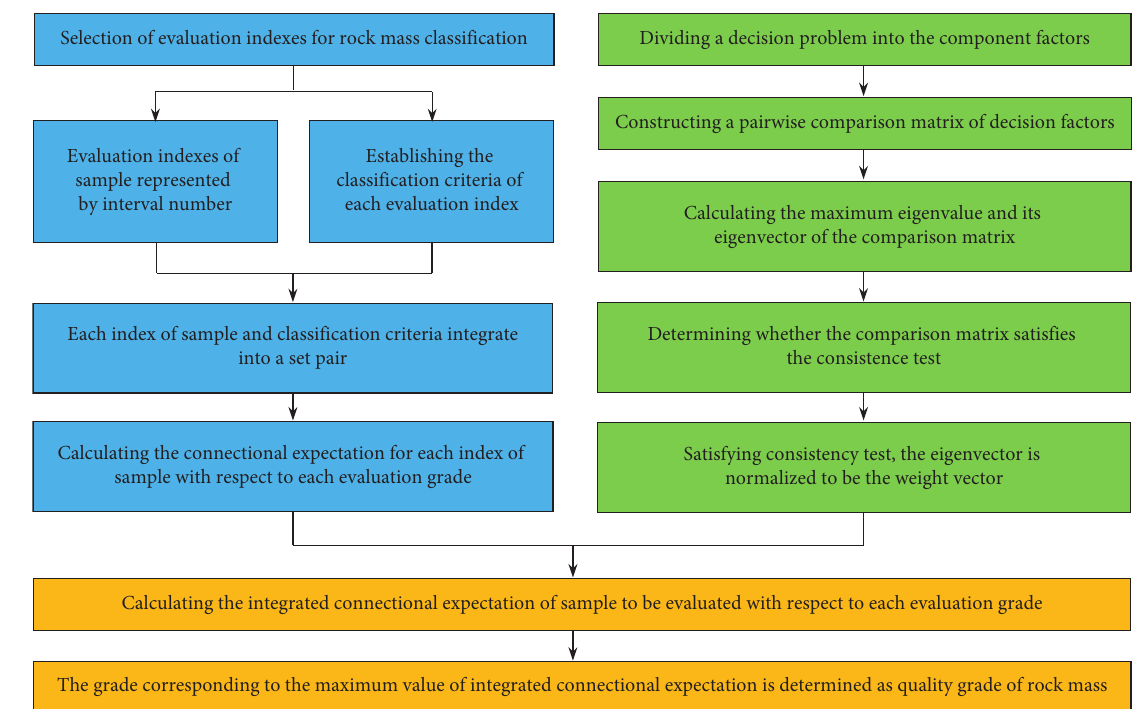
Figure 7: Flowchart for the rock mass quality evaluation model based on connectional